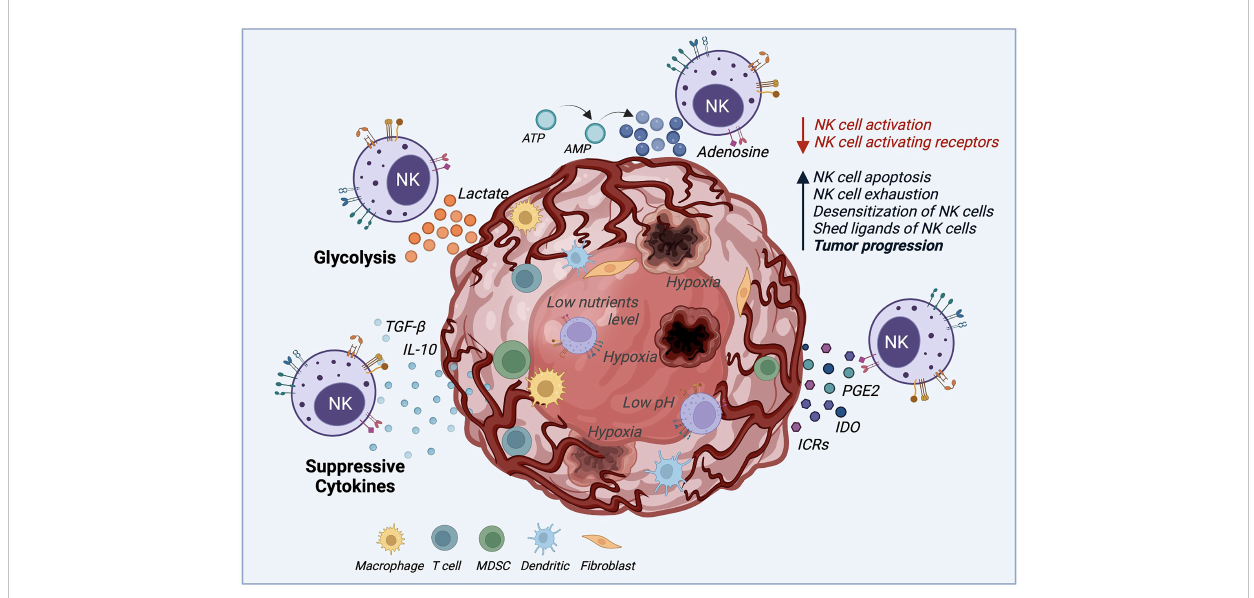
FIGURE 2 Tumor microenvironment (TME) mechanisms inhibiting NK cell cytotoxicity. The TME deploys several mechanisms to survive and increase the tumor progression rate by desensitizing NK cells and decreasing NK cell activation. These mechanisms negatively impact NK cell cytotoxicity by boosting NK cell apoptosis, exhaustion, and proliferation. Suppressive cytokines such as TGF- b and IL-10, immune-checkpoint receptors (ICRs), indoleamine 2,3-dioxygenase (IDO), prostaglandin E2 (PGE2) are secreted by the TME to desensitize NK cells. Also, the production of lactate and adenosine, along with hypoxia, and low levels of nutrients and pH, inhibits the NK cell function against solid